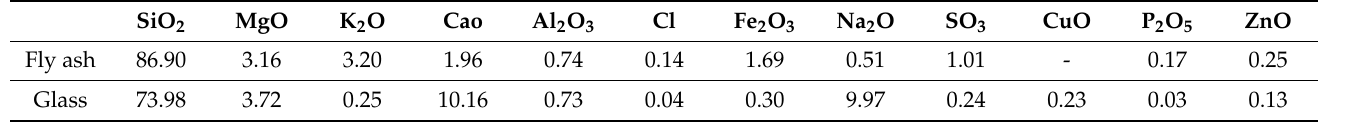
Table 1. The particle size of glass and fly ash powder is shown in Table 2. Table 1. The chemical compositions of glass and fly ash powder.